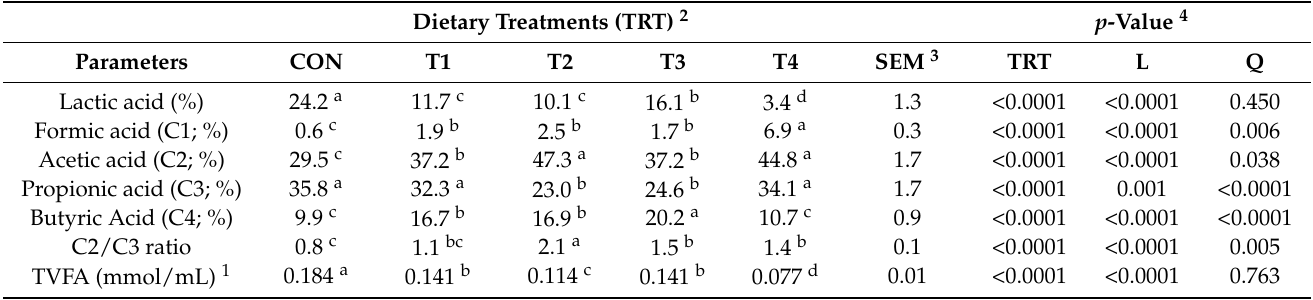
Table 5. Effect of dietary treatments on rumen volatile fatty acid concentrations of growing